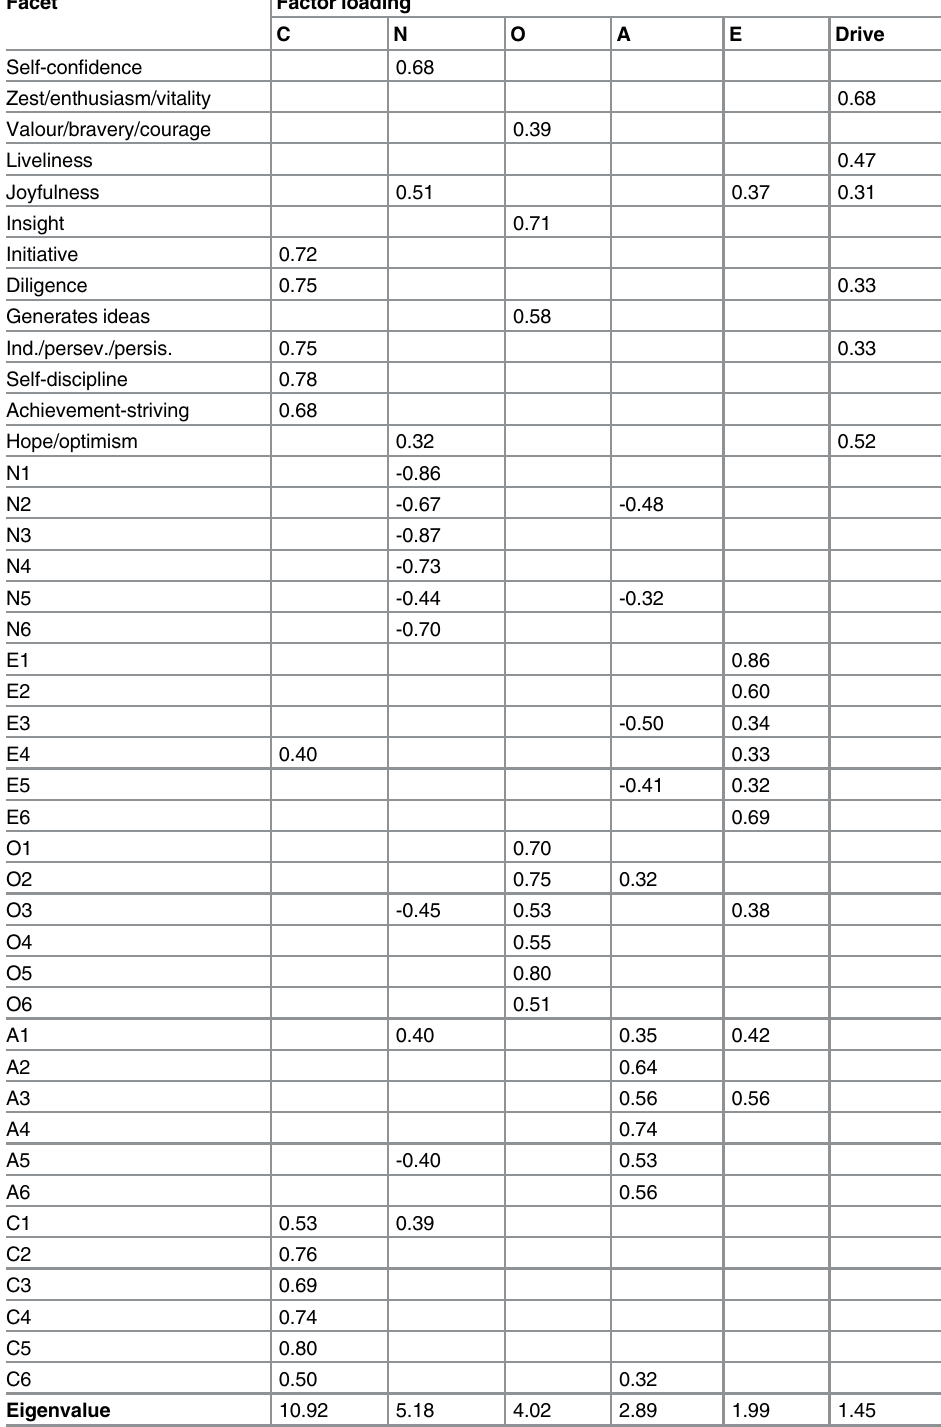
Table 9. Promax-Rotated Pattern Matrix for Drive:IPIP and NEO PI-R Facets in the Eugene-Springfield Community